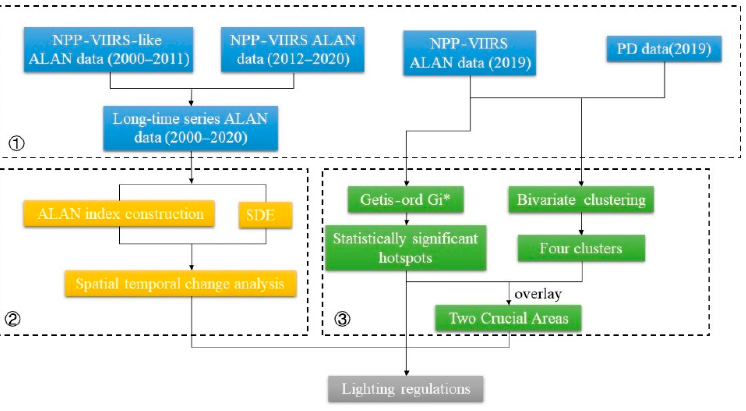
Figure 2. The flowchart of the methodology.